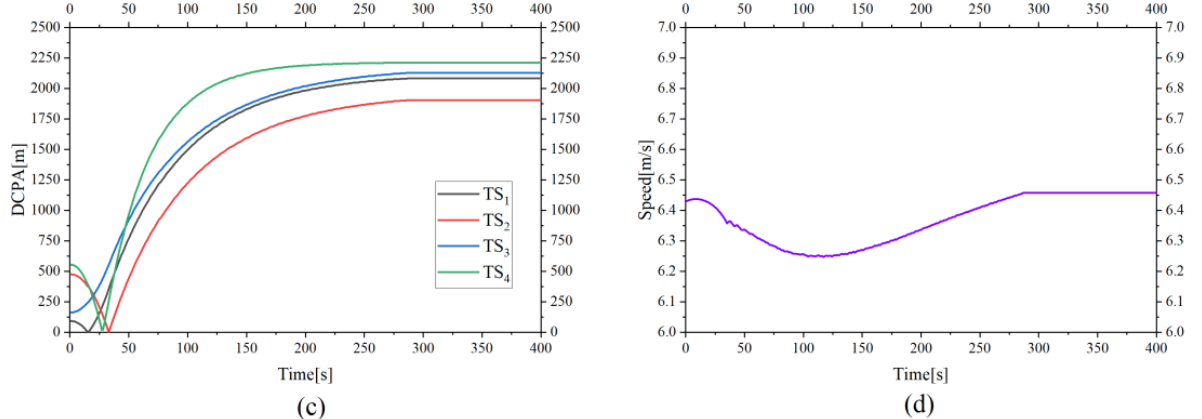
Figure 15. Simulation results of scenario 2: ( a ) Trajectory of OS and TSs; ( b ) Distance between OS and different TSs; ( c ) DCPA between OS and different TSs; ( d ) Speed of OS.